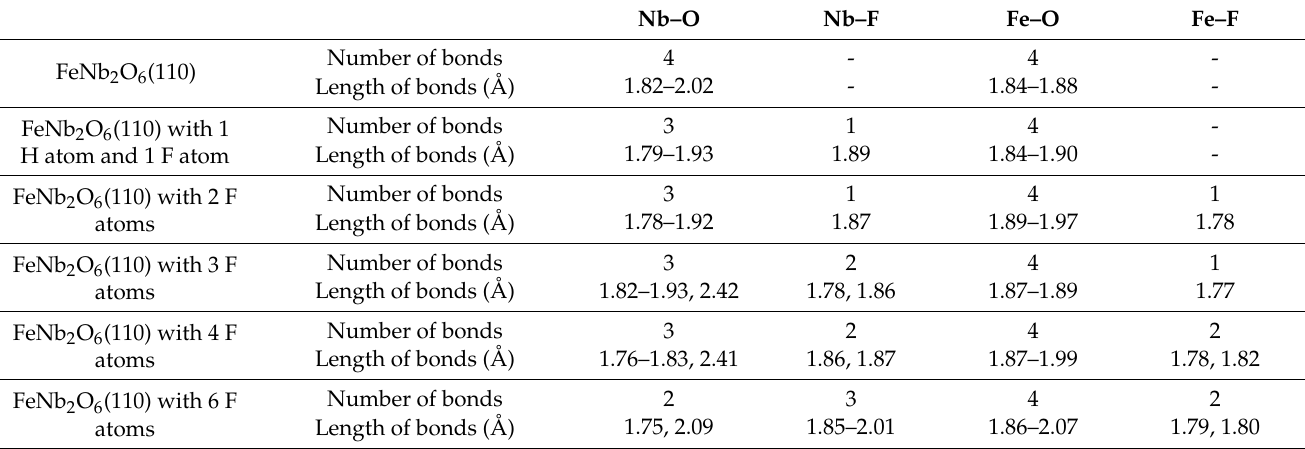
Table 1. Mulliken populations and bond lengths of some Nb–O and Nb–F in FeNb 2 O 6 before and after HF acid